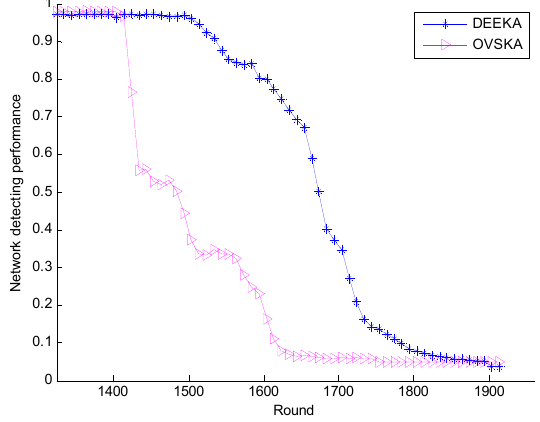
Figure 10. Network detecting performance with the number of network running rounds.